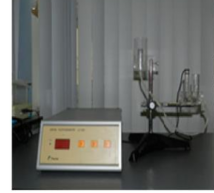
Figure 1. Plethysmometer LE